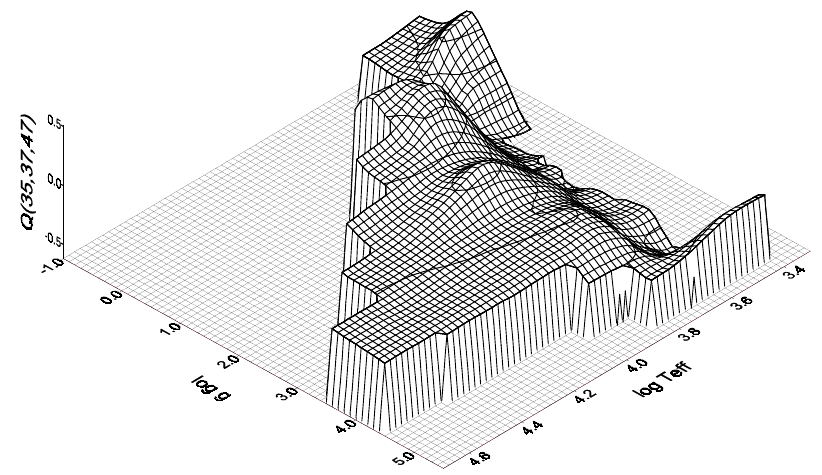
Fig. 4. Three-dimensional diagram of the Q 35,38,46 parameter ver- sus log T e and log g . The five curves on the surface correspond to the Q values of –0.4, –0.2, 0.0, 0.2 and